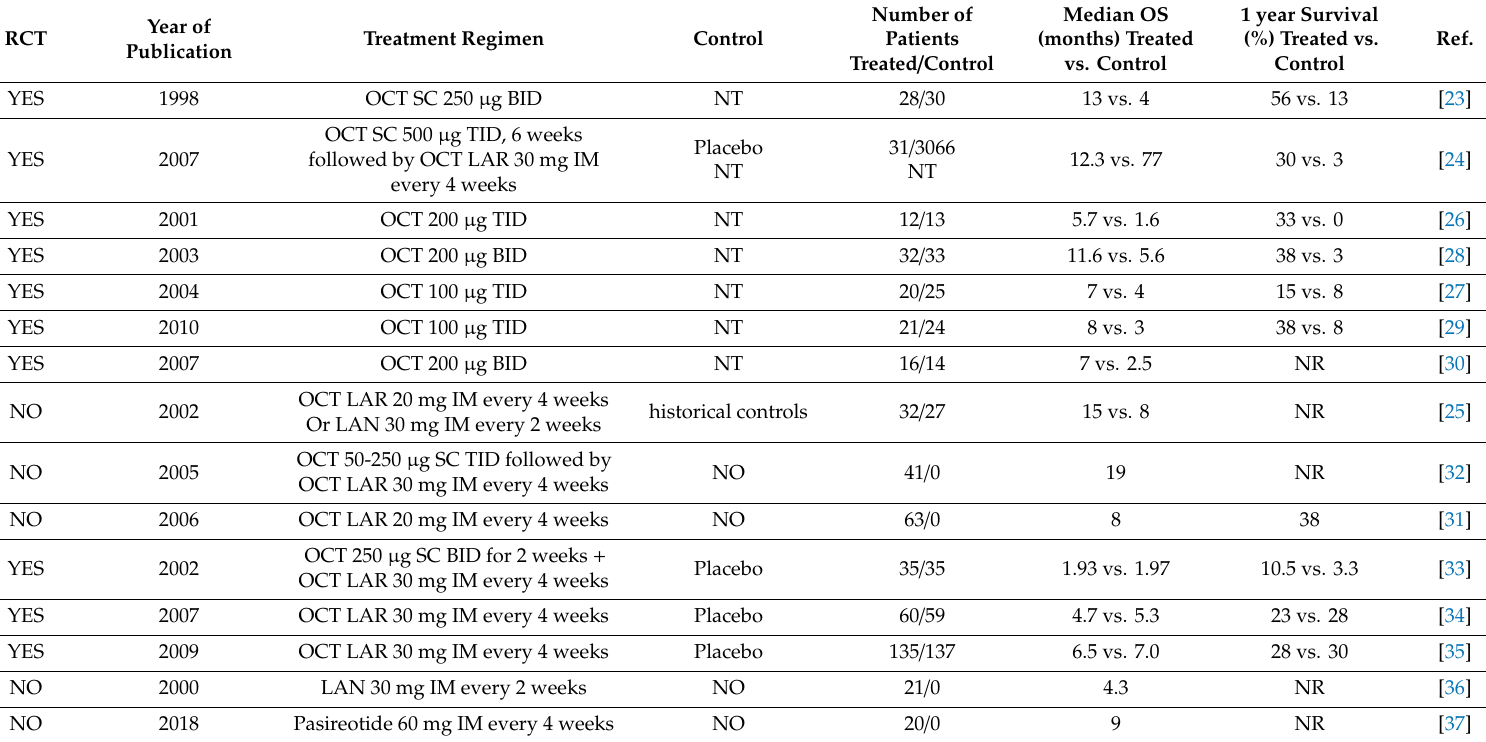
Table 1. Trials evaluating somatostatin (SST) Analogues for advanced Hepatocellular Carcinoma. RCT